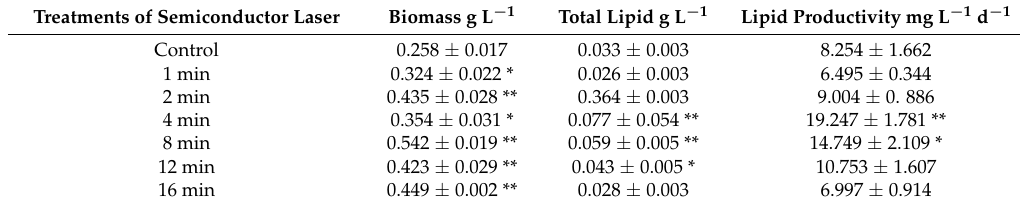
Table 3. Biomass concentrations, total lipid content, and lipid productivity of C. pacifica treated by semiconductor